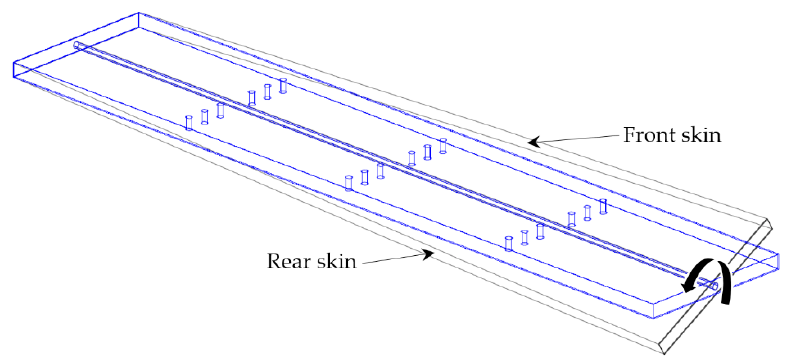
Figure 1. New concept morphing wings presented torsion beam.